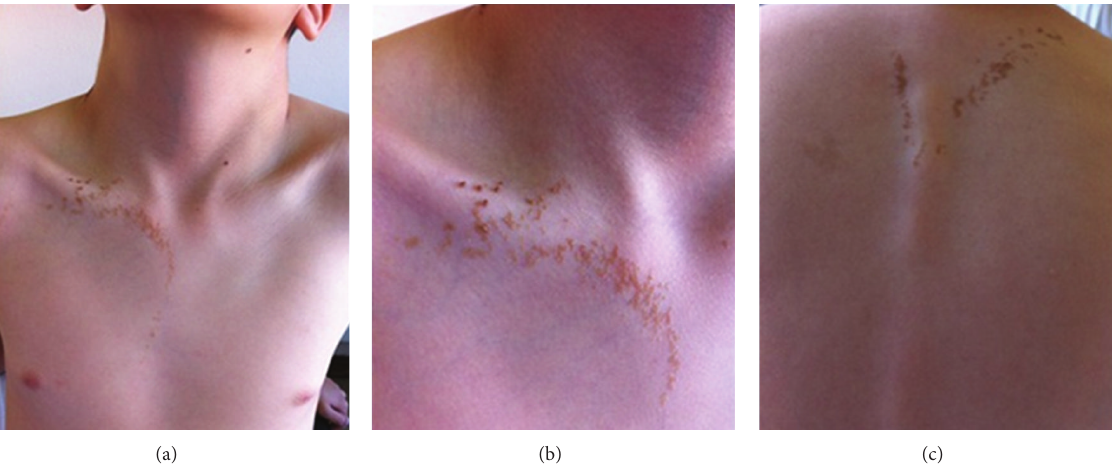
Figure 2: Linear brown verrucous plaques on the right side of the chest and upper dorsum (a)–(c).